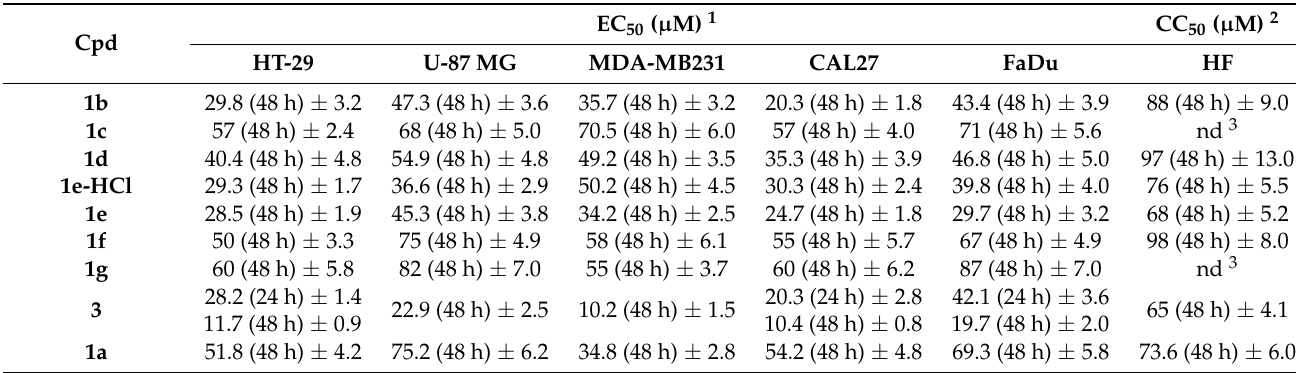
Table 2. Cytotoxicity and antitumor activities of the newly synthesized compounds 1b – g and 3 in comparison with reference compound 1a .